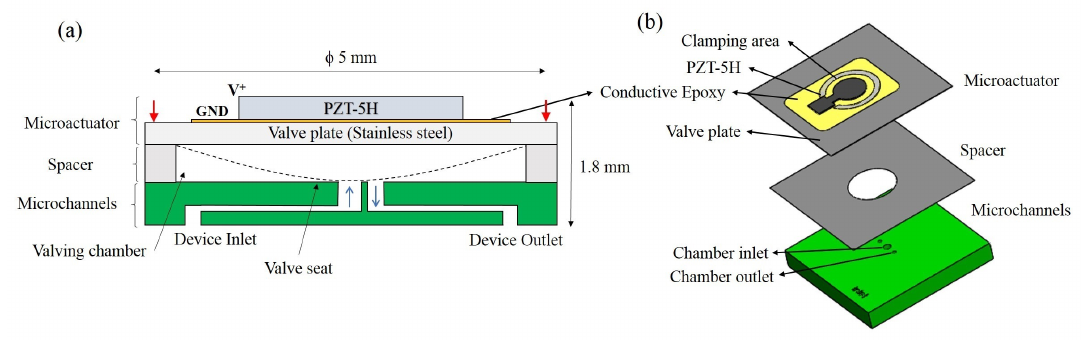
Figure 1. ( a ) Schematic of the microvalve: It consists of a circular piezoelectric unimorph microactuator, a spacer, and 3D-printed microchannels. The microactuator is placed on top of the microchannels with an intermediate spacer and the entire assembly is clamped. Red arrows indicate the direction of the clamping force. Black dashed lines indicate the membrane deformation when actuated. ( b ) Exploded 3D view of the